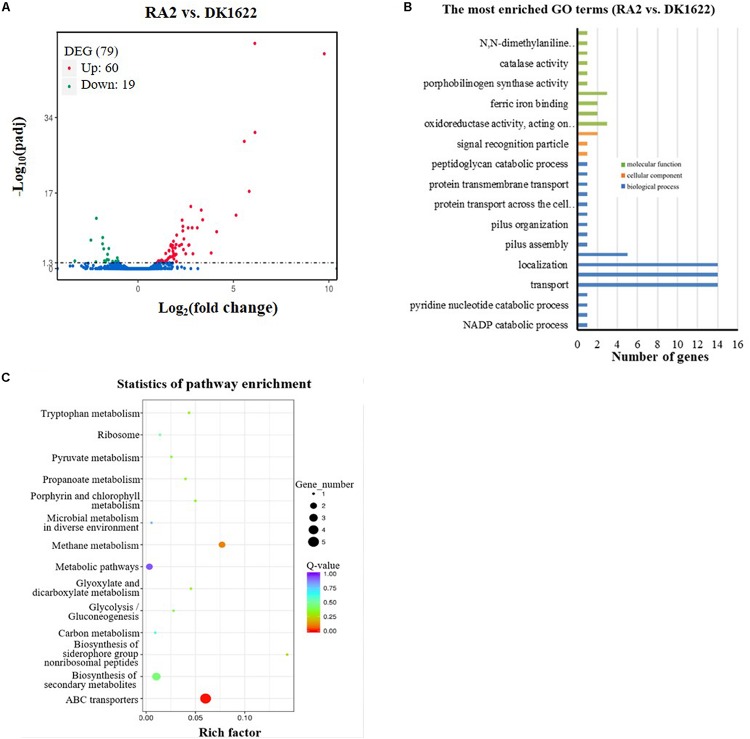
Comparison of transcriptomes between the recA2 mutant (RA2) and the wild-type strain (DK1622). (A) Volcano plot of differentially expressed gene (DEG) distributions. Red dots and green dots represent the up- and down-regulated genes with significant differences, respectively (padj. < 0.05). The blue dots represent the genes that have not changed significantly. (B) The distribution of GO category and (C) pathways of DGEs between RA2 and DK1622. Enriched GO is shown in three categories: biological process (blue), molecular function (green), and cellular component (orange).